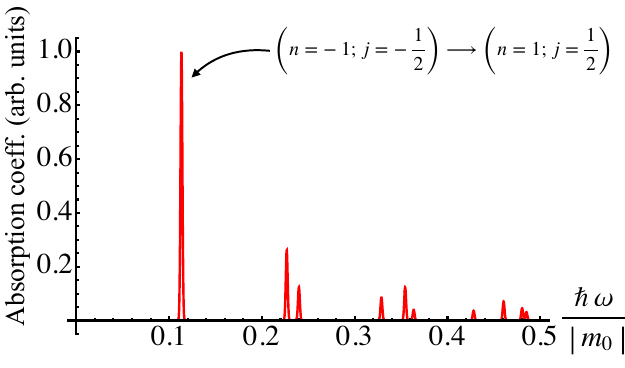
Figure 7: The absorption spectrum for a nanocylinder with R = 20 R L = 10 R . The peaks have been modelled by Gaussian curves with stan- 0 | . The dominant peak corresponds to the transition dard deviation 10 − 3 | m 0 ( n = − 1, j = − 1 / 2 ) → ( n = 1, j = 1 / 2 ) . The dipole matrix elements have been com- puted by means of the tight-binding model with discretisation constants a = 0.05 R and a z 0